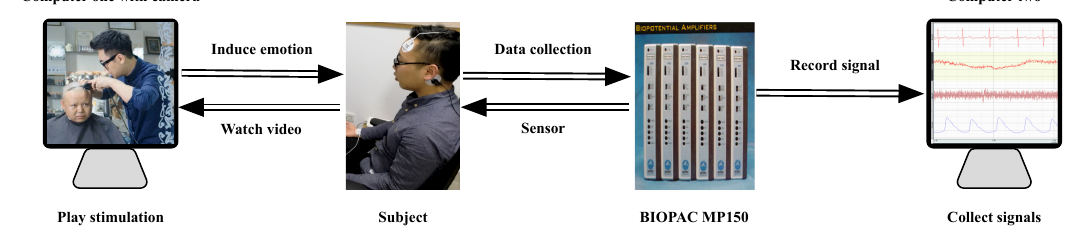
Figure 5. The diagram of experiment